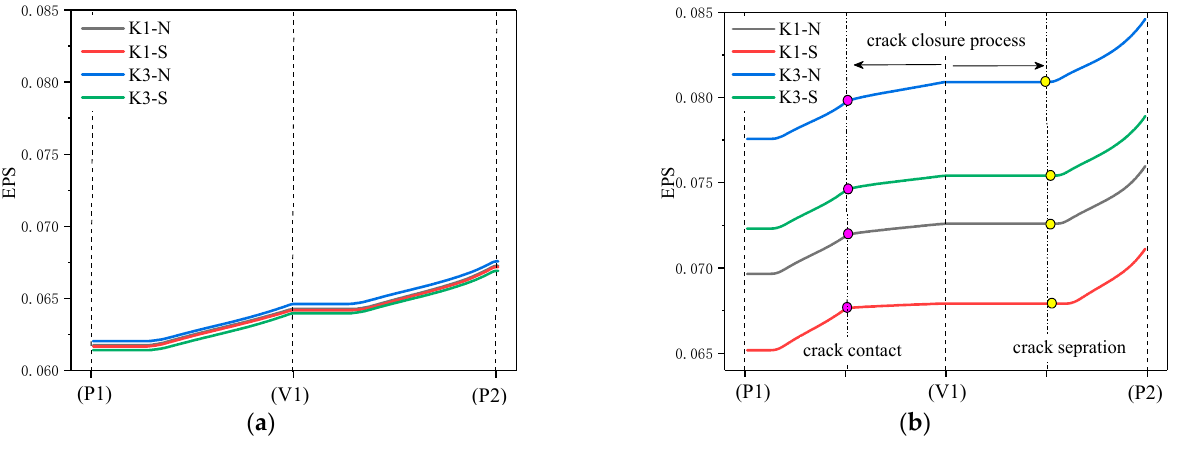
Figure 10. Effect of specimen type on EPS distribution: ( a ) R = 0, ( b ) R = − 1. Conclusions have been drawn from Figures 3 and 4, that is B (K1) > B (K3), CL(K1) < CL(K3), C (Ki-S) > C (Ki-N)(i = 1, 3), based on which strain evolution is discussed. Firstly,